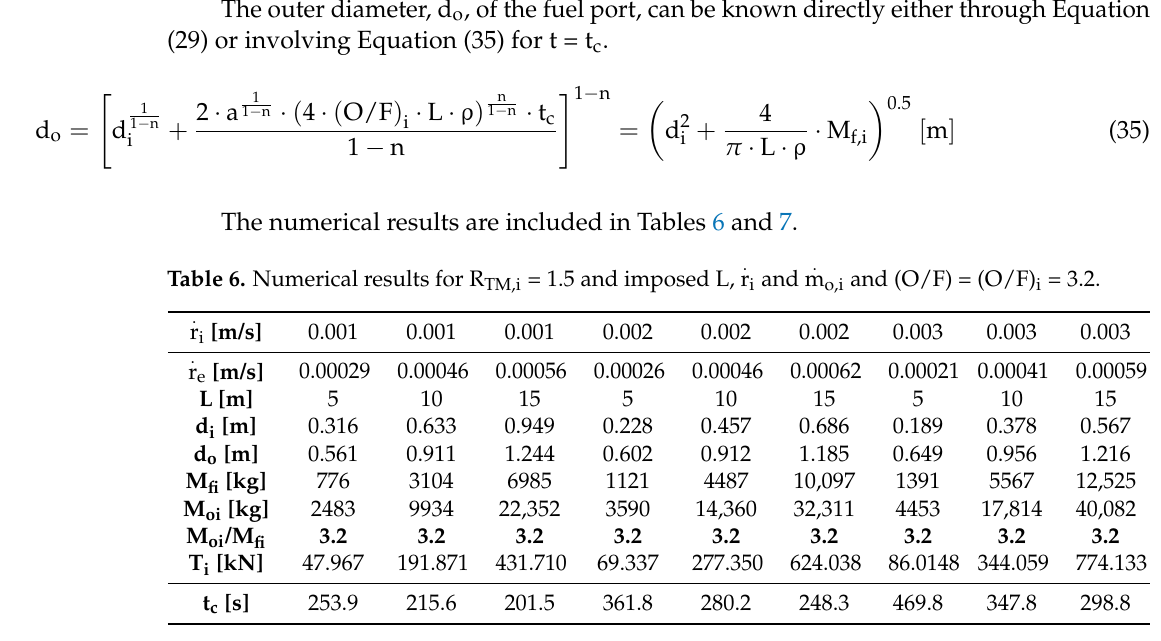
. . r i and m o,i and (O/F) = (O/F) i =